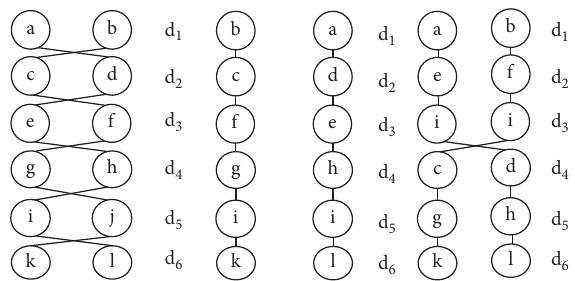
Figure 1: Association rule distribution model of large-scale in- formation management